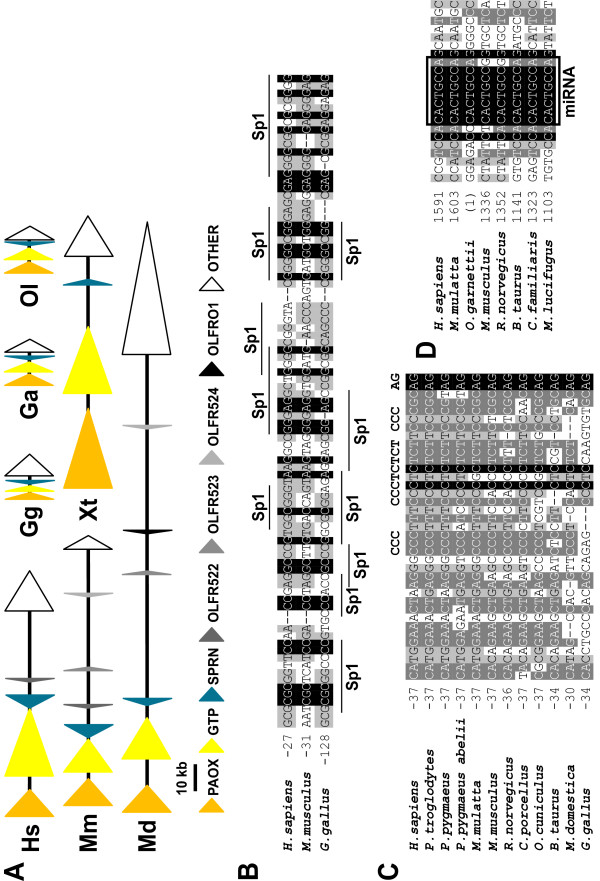
Comparative genomic analysis of SPRN. (A) Gene order and relative gene orientations in the local SPRN genomic contexts located on the human chr. 10 (Hs), mouse chr. 7 (Mm), gray short-tailed opossum chr. 1 (Md), chicken chr. 6 (Gg), western clawed frog scaffold_502 (Xt), Japanese medaka chr. 15 (Ol) and three-spine stickleback chr. 6 (Ga). Detailed genomic sequence coordinates were given in section 4.1. Gene names were explained in the main text. Genes were drawn approximately to scale. The horizontal bar shows 10 kb sequence length. (B) Conserved region in SPRN promoters. Sequence coordinates were calculated relative to introns. Horizontal lines denote predicted Sp1 sites in human (above alignment) and chicken (below alignment). (C) Conserved region in SPRN introns. Sequence coordinates were calculated relative to exon 2. CCC, C-rich intron splicing enhancer sequence; CTCTCT, polypyrimidine tract-binding protein-binding site sequence; AG, 3' intron splice site sequence. (D) Conserved motifs in the conserved SPRN 3'-UTR region 7. Sequence coordinates were calculated relative to ORFs where possible. miRNA, potential hsa-miR-34a site (CACTGCCA). (B-D) White letters on black background indicate conservation in 100% sequences, white letters on dark gray background indicate conservation in ≥75% sequences and black letters on light gray background indicate conservation in ≥50% sequences. Ga, Gasterosteus aculeatus; Gg, Gallus gallus; Hs, Homo sapiens; Md, Monodelphis domestica; Mm, Mus musculus; Ol, Oryzias latipes; Xt, Xenopus tropicalis.